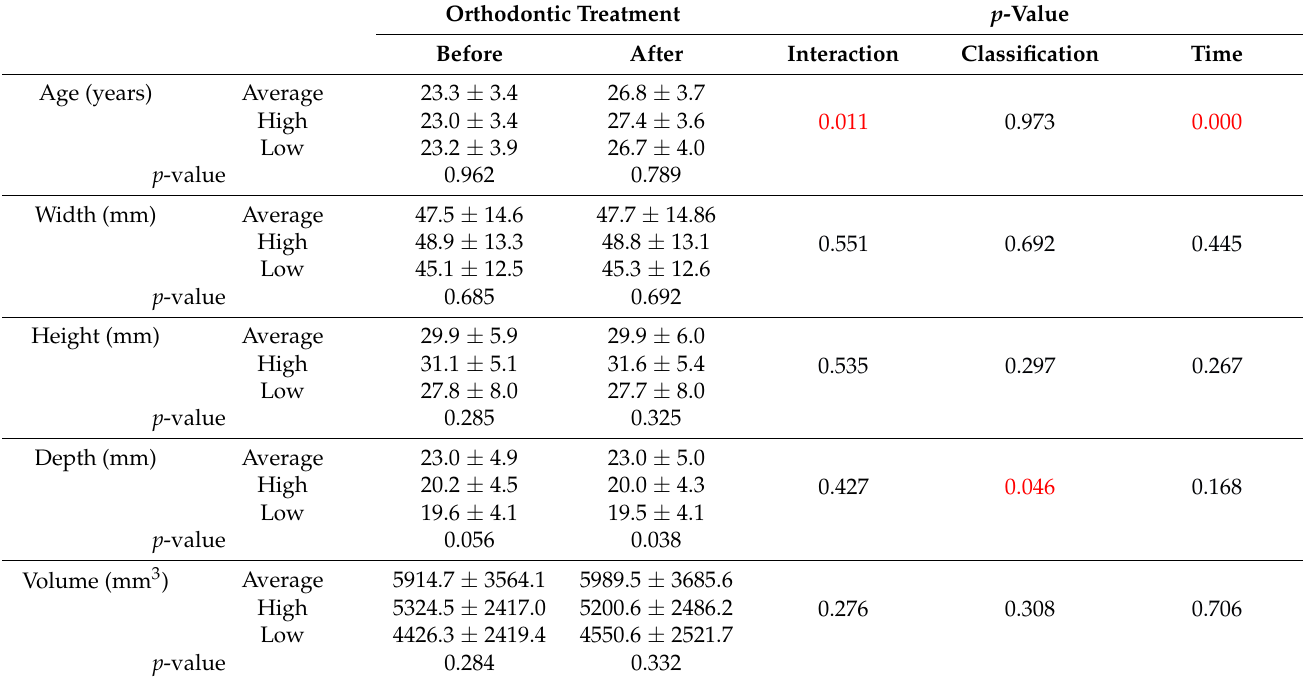
Table 2. Pre-treatment and post-treatment size and volume of the frontal sinus. Orthodontic Treatment p -Value Before After Interaction Classification